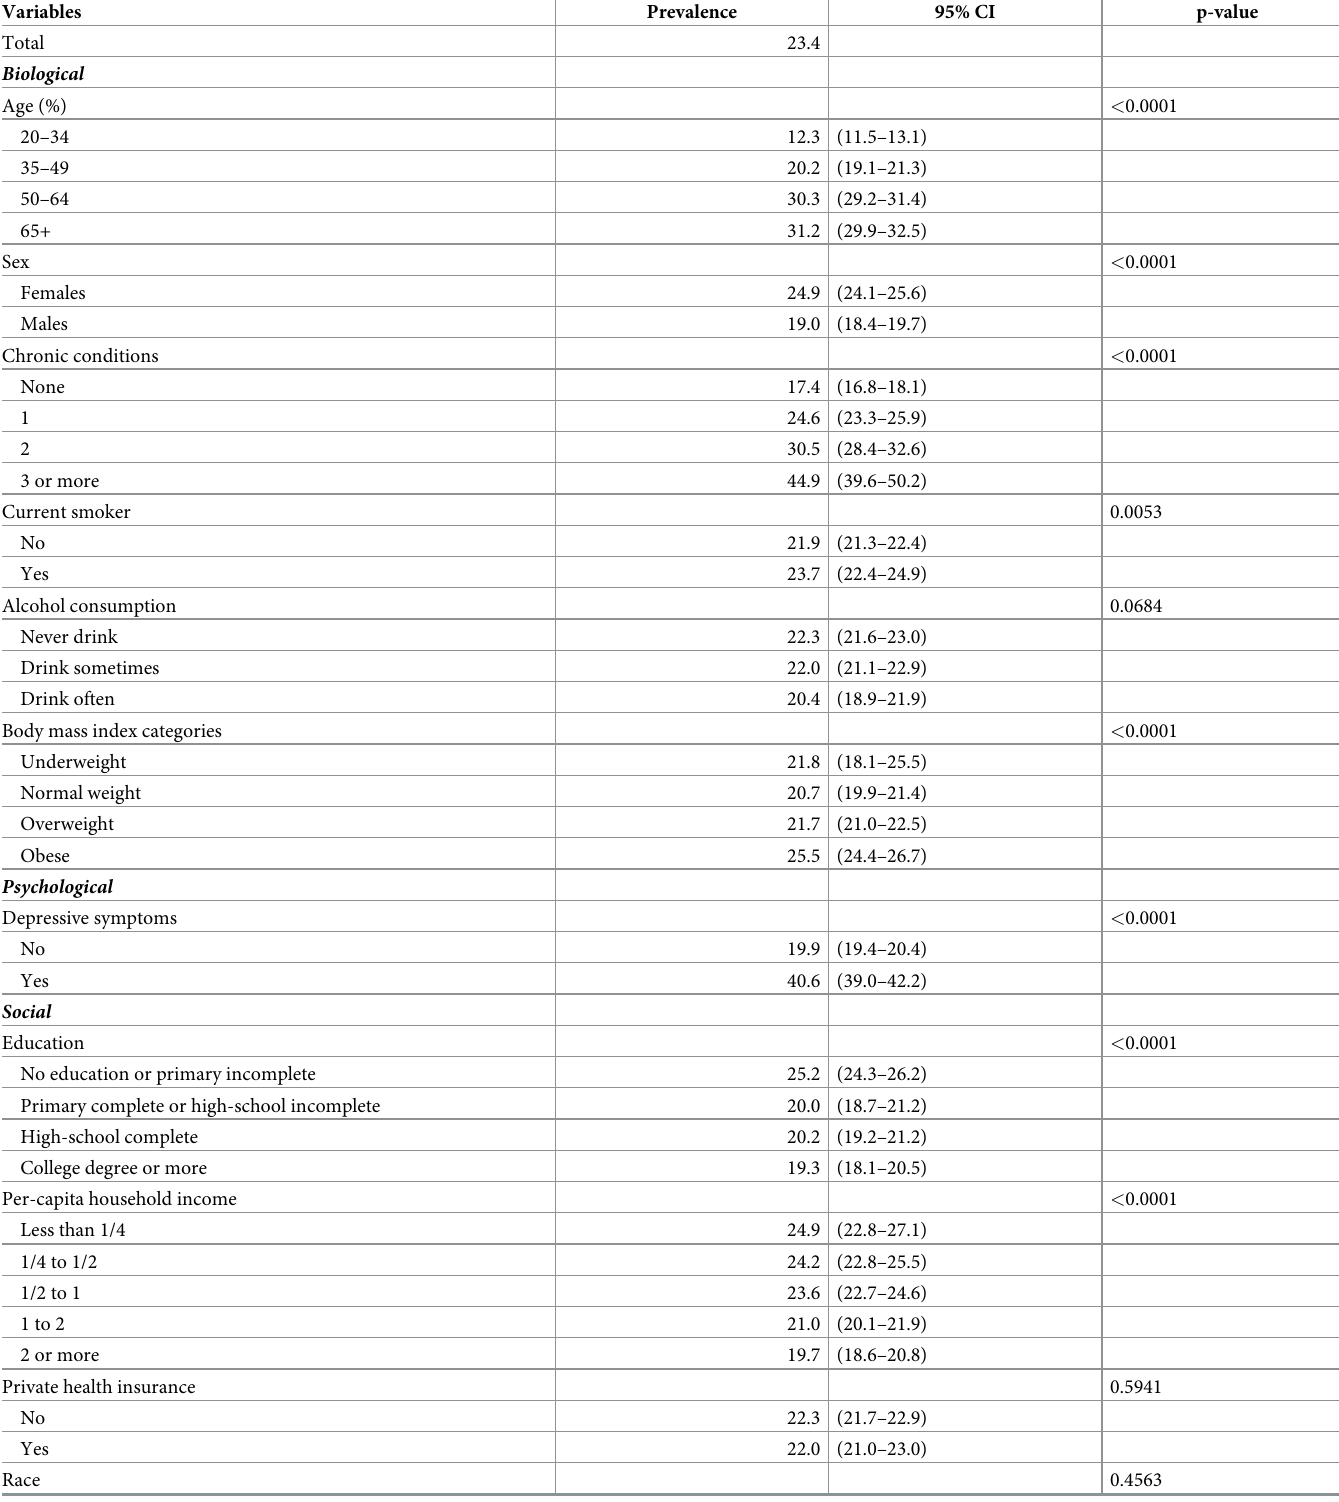
Table 2. Age-adjusted prevalence rates of chronic back